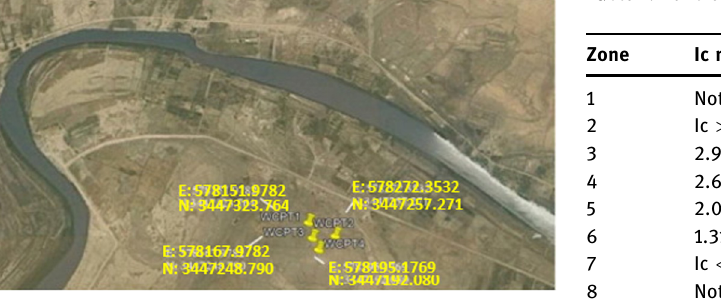
Table 1: Zone of soil based on Ic values ( Robertson, 2010